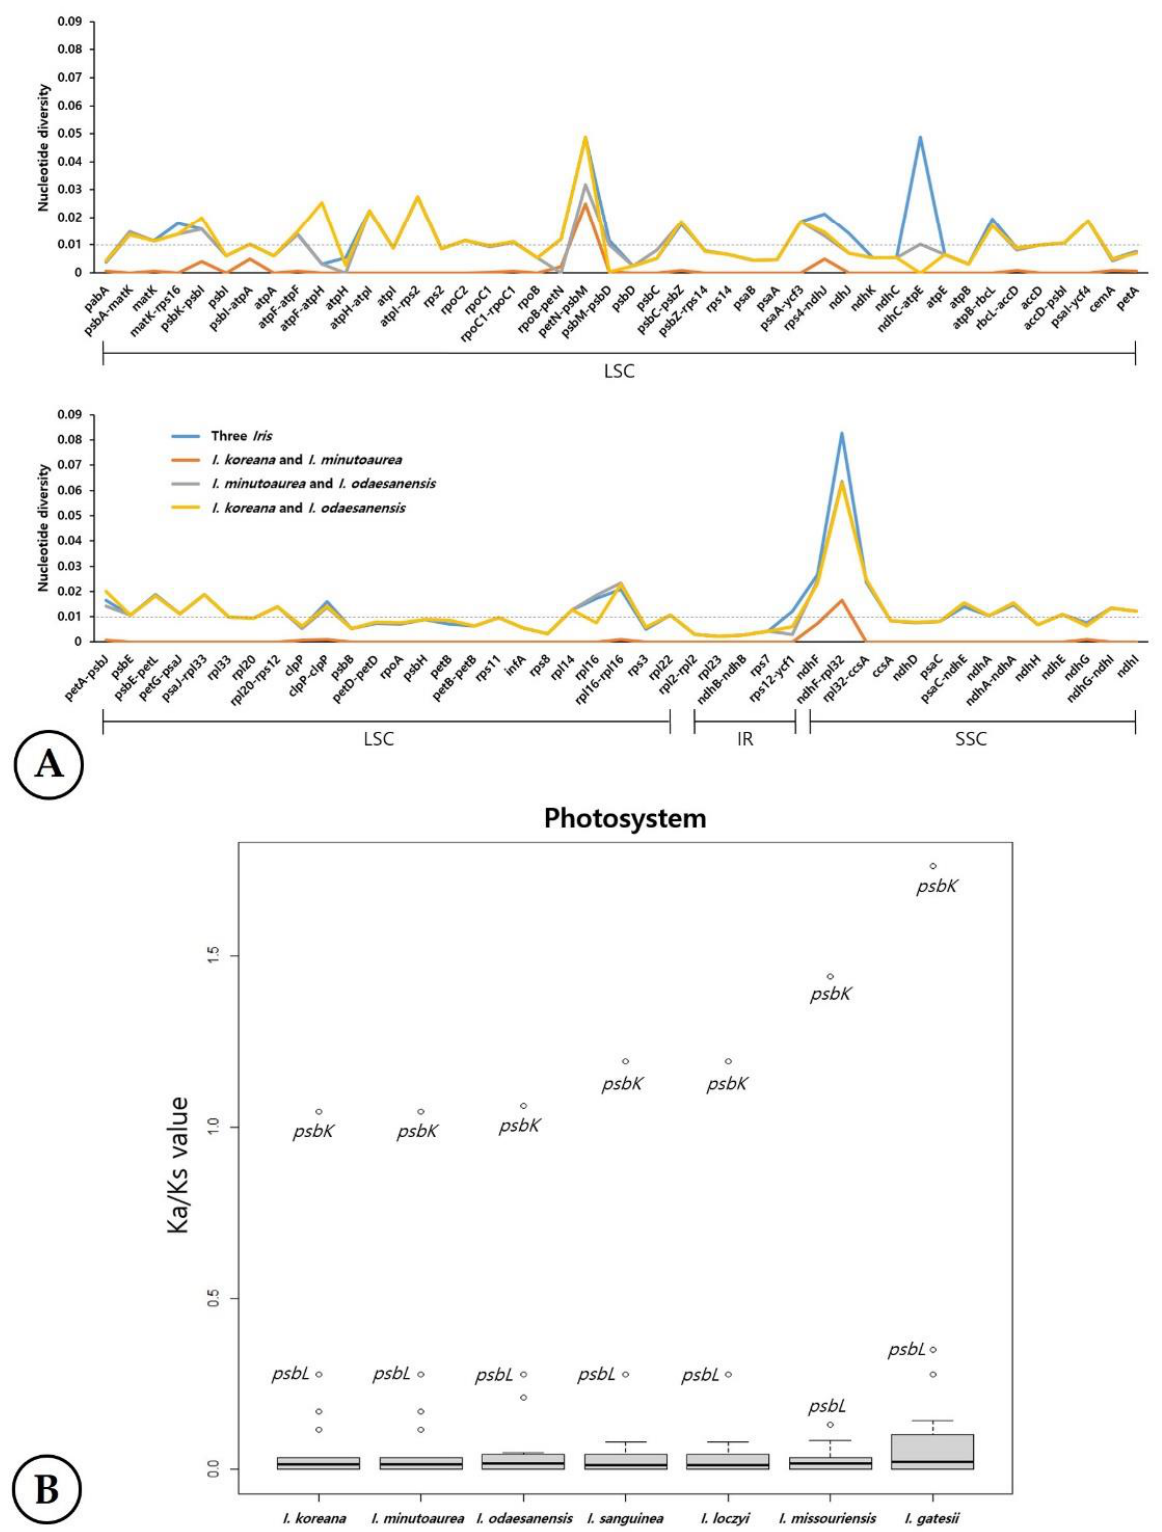
Figure 6. ( A ) Comparisons of the nucleotide diversity (Pi) values among the cp genes of the three analyzed Iris species. The mean of Pi value for all analyzed genes of the three Iris species is indicated with the dotted line. ( B ) Ka/Ks values for the photosystem-related genes in the Iris cp genomes.